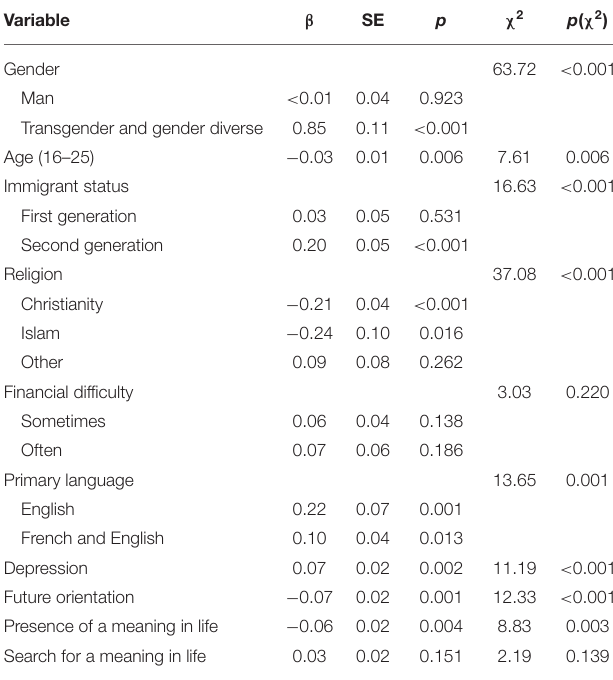
TABLE 4 | Results from linear mixed-effects model with support for violent radicalization as dependent